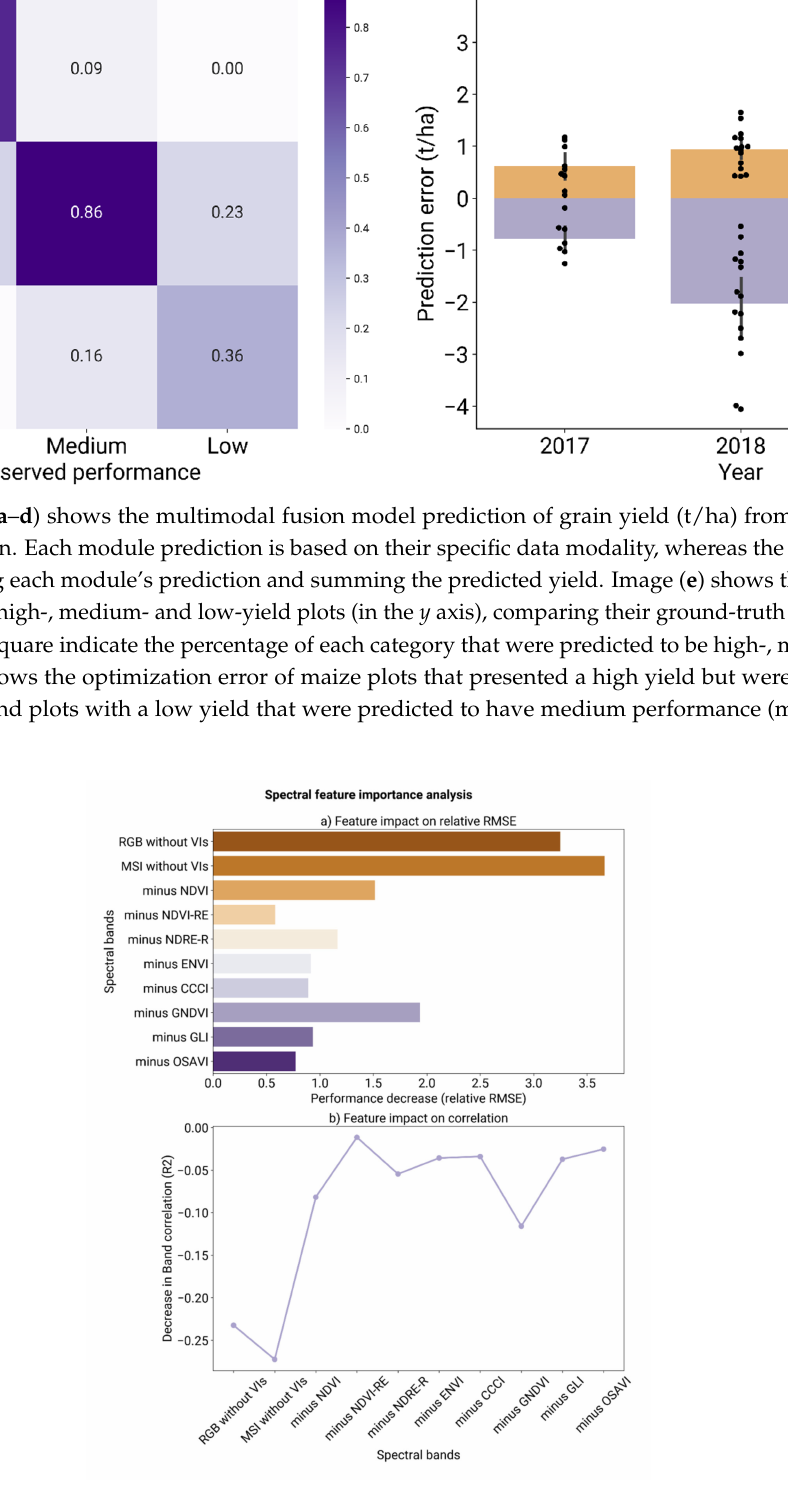
Figure 8. Prediction results from the permutation analysis. Image ( a ) shows the impact of random- ization on model performance, the x -axis indicates if all VIs were randomized (MSI or RGB) or if only one VI was randomized (minus VI); the y -axis indicates the relative RMSE obtained. Image ( b ) shows the impact of feature randomization on the correlation between features and grain yield. MSI refers to the original multispectral bands (red, green, blue, near-infrared and red